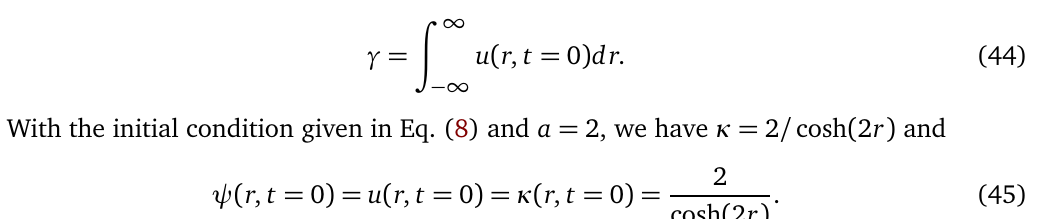
Figure 17: Left panel: LL energy current J = function of the position r for different times. Right panel: same data, multiplied by t and plotted as a function r / t . An excellent collapse is observed for r / t (cid:166) 1.5. (cid:126) M = ( cos ( θ ( r )) ,sin ( θ ( r )) ,0 ) and the curvature is given by κ = | θ > 0 everywhere, the filament function is simply given by u = θ that θ r